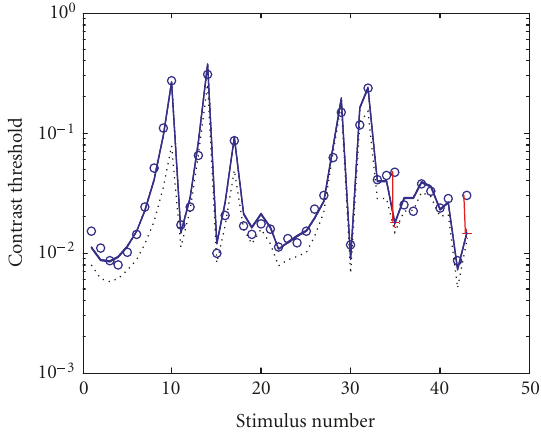
Figure 4: Contrast thresholds of 43 Modelfest stimuli. The data points (circles) represent mean experimental results over 16 ob- servers; the dotted lines represent model predications with an RMS error of 0 . 22 log unit; and the solid lines represent optimal model fits with an RMS error of 0 . 11 log